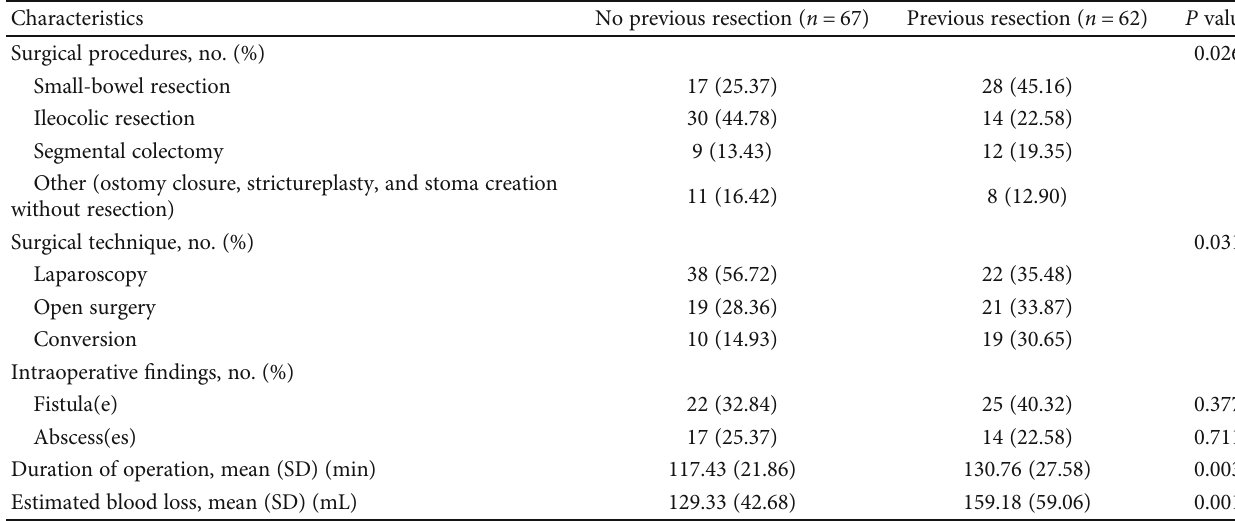
Table 2: Surgical